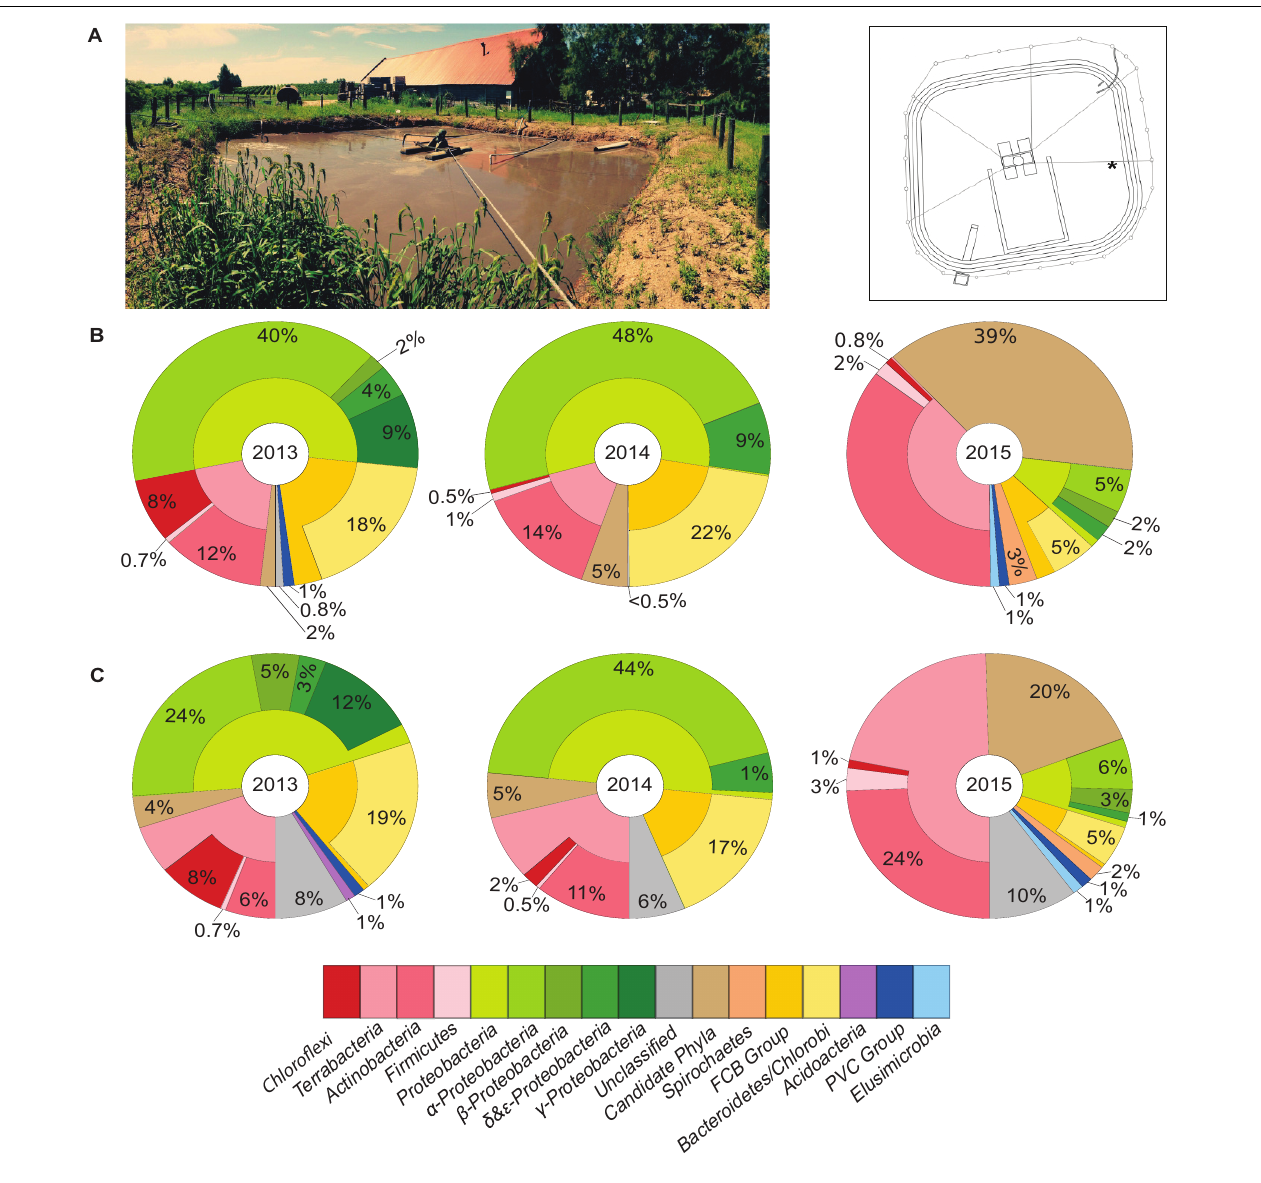
FIGURE 2 | (A) Aerated lagoon (LEA) of wastewater treatment plant in Uruguay and its cross-sectional view. The star indicates the exact location where samples were taken. Taxonomic composition of the bacterial community in LEA samples collected in 2013, 2014, and 2015 based on (B) 16S rRNA gene sequences and (C) single-copy marker